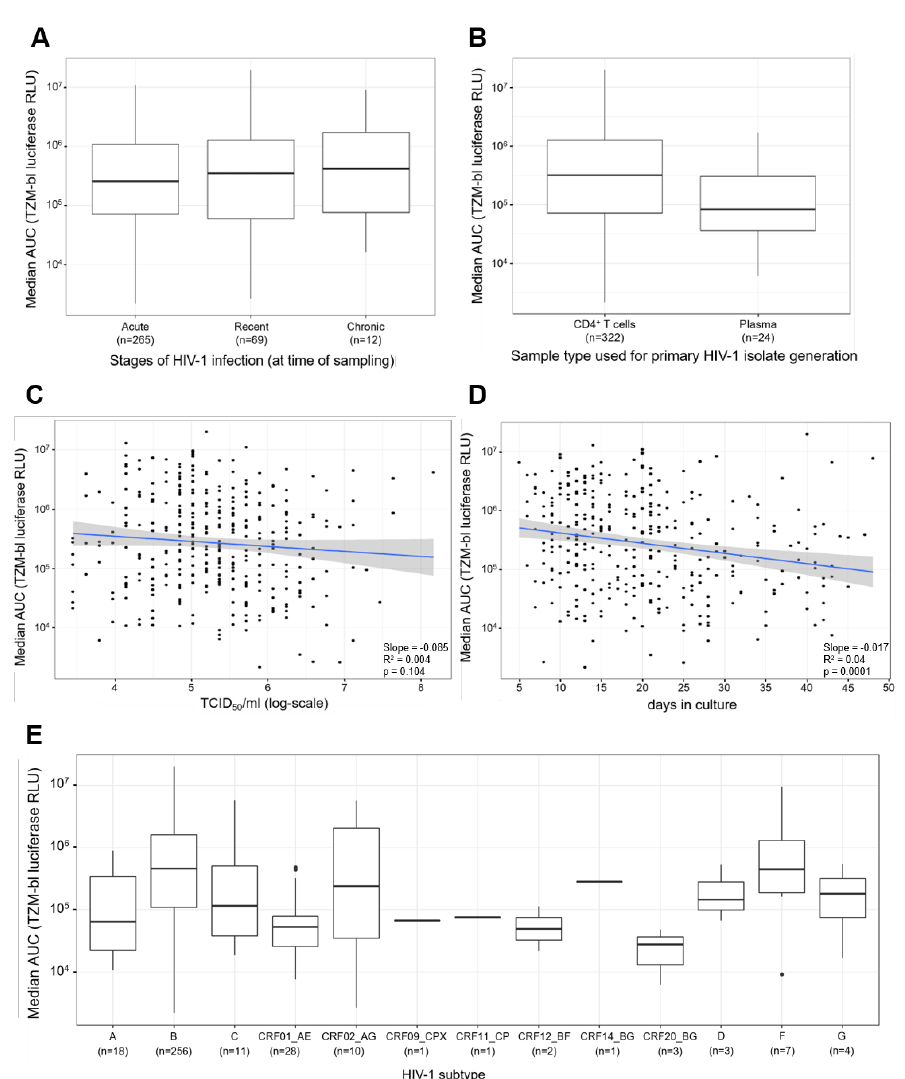
Figure 5. Comparisons of primary HIV-1 isolate replication capacities to stages of infection, types of samples used for generation of primary HIV-1 isolates, viral titers of virus stocks, days in culture, and HIV-1 subtypes. ( A ) Comparison of replication capacities of primary HIV-1 isolates for the different stages of HIV-1 infection. The x-axis represents the three stages of infection: acute, recent, and chronic, and the number (n) of primary HIV-1 isolates in each stage of infection. The y-axis represents the median AUC values of the replication capacities in log scale. The Wilcoxon signed-rank test was performed for comparisons between two groups and the Kruskal–Wallis test was performed for comparisons of more than two groups. ( B ) Comparison of the replication capacities of primary HIV-1 isolates derived from CD4 + T cells or plasma. The x-axis depicts the 2 types of samples used to generate the primary HIV-1 isolates, and the number (n) of primary HIV-1 isolates derived from the corresponding sample type. The y-axis represents the median AUC values of the replication capacities of the primary HIV-1 isolates. ( C ) Comparison of the viral titers of the primary HIV-1 isolate stocks to the corresponding replication capacities. The x-axis represents the tissue culture infectious dose of 50% per ml in log-scale. The y-axis depicts the median AUC values of the replication capacities for the primary HIV-1 isolates. ( D ) Comparison of the number of days the T/F primary isolates were in culture on the x-axis against the median AUC values of the replication capacity of the viruses on the y-axis, in log scale. The graph shows the OLS regression results (blue line) and its standard error (gray shading). ( E ) Comparison of the distribution of the replication capacity for different HIV-1 subtypes. The x-axis represents the various HIV-1 subtypes and the number (n) of each subtype. The y-axis depicts the replication capacities of T/F viruses represented as median AUC values. The black dots represent outliers, identified as values that are more than 1.5 times the interquartile range removed from the first or third quartile. The Kruskal Wallis test was performed to compare the median AUC values among the different HIV-1